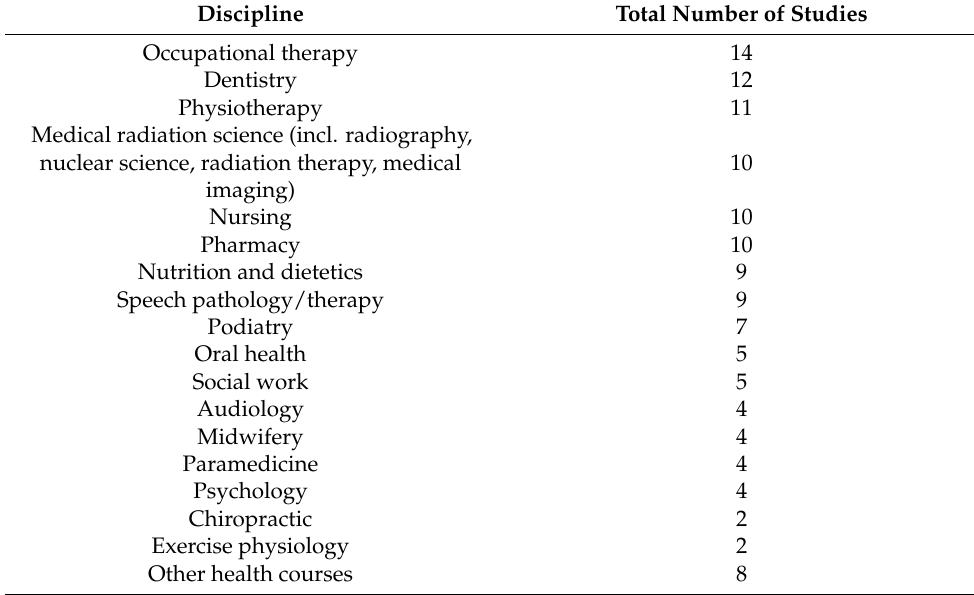
Table 2. Disciplines of health placements included in the